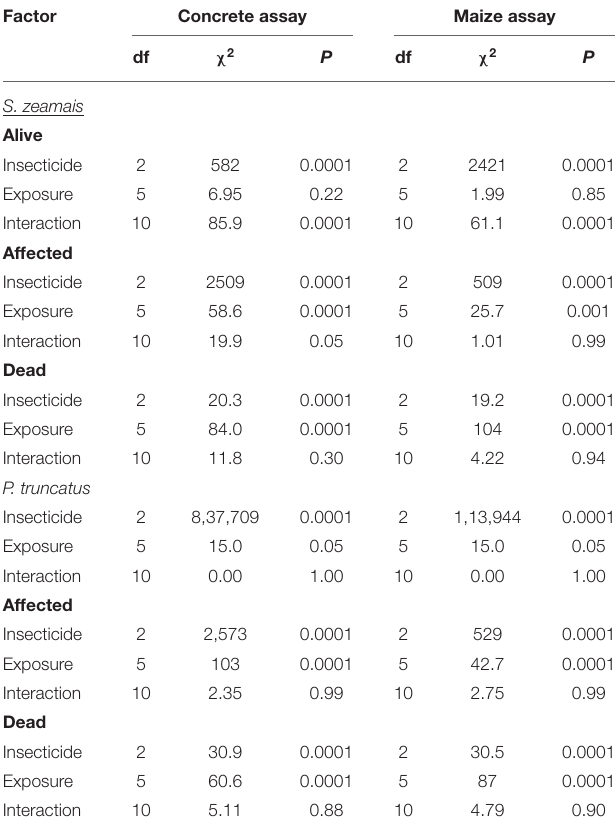
TABLE 2 | Summary of statistical GLM model results for mortality of S. zeamais and P. truncatus in the concrete assay and maize